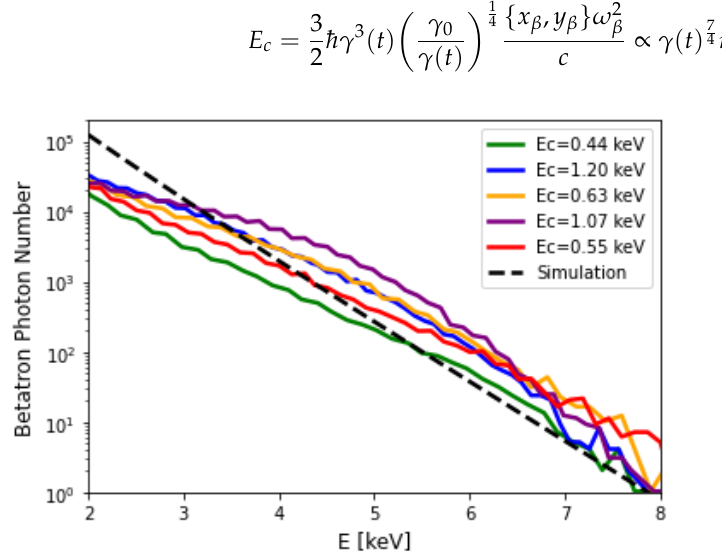
Figure 8. Measurements of betatron radiation spectra. For “Betatron Photon Number”, ∼ ( dN / d ω ) × ∆ ω with ∆ ω = 0.13 keV , which the resolution of the diagnostic